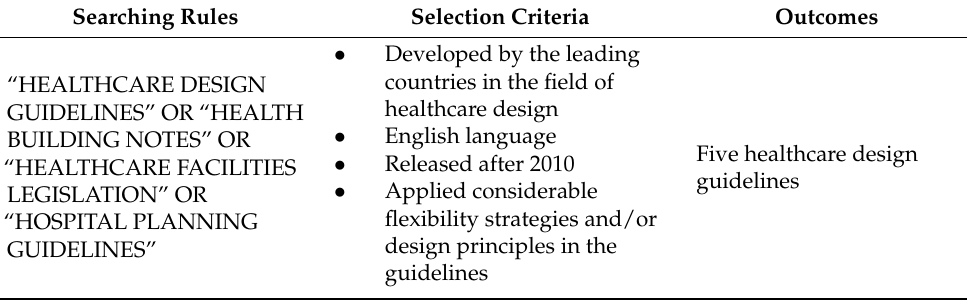
Table 2. Searching rules and selection criteria for review of healthcare design guidelines Searching Rules